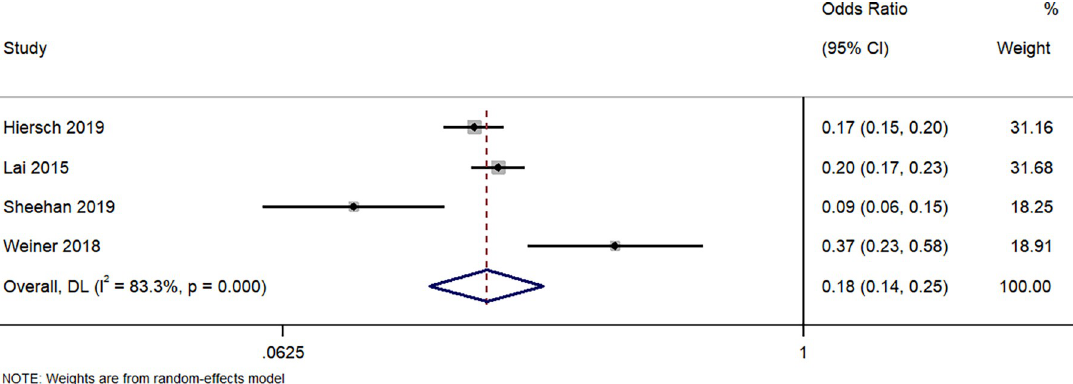
Fig 10. Forest plot showing the difference in NICU admission between women with a singleton pregnancy or twin pregnancy and GDM. NOTE: Weights are from random-effects model.